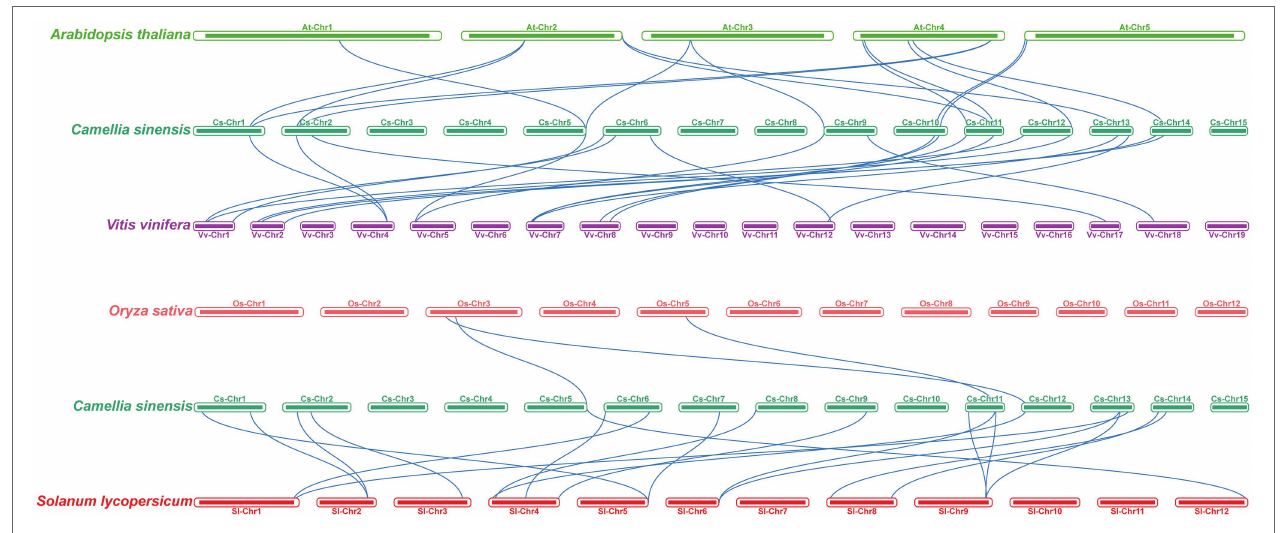
TABLE 1 | The evolutionary analysis of duplicated m6A regulatory genes in tea plants. Gene 1